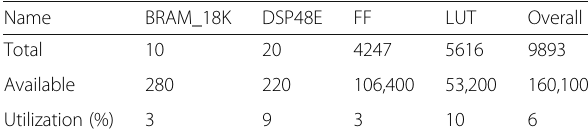
Table 9 Detailed FP (31, 11) fixed-point OCR utilization